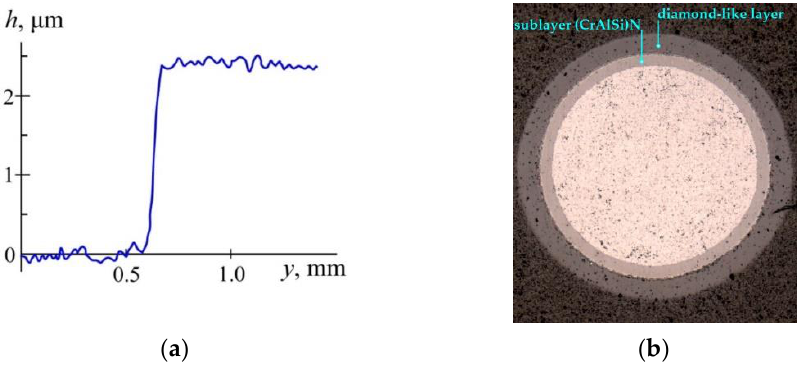
Figure 11. Profilogram of the end mill surface without the detached mask ( a ) and construction of a two-layer DLC coating deposited on a 3-mm-diameter end mill ( b ).